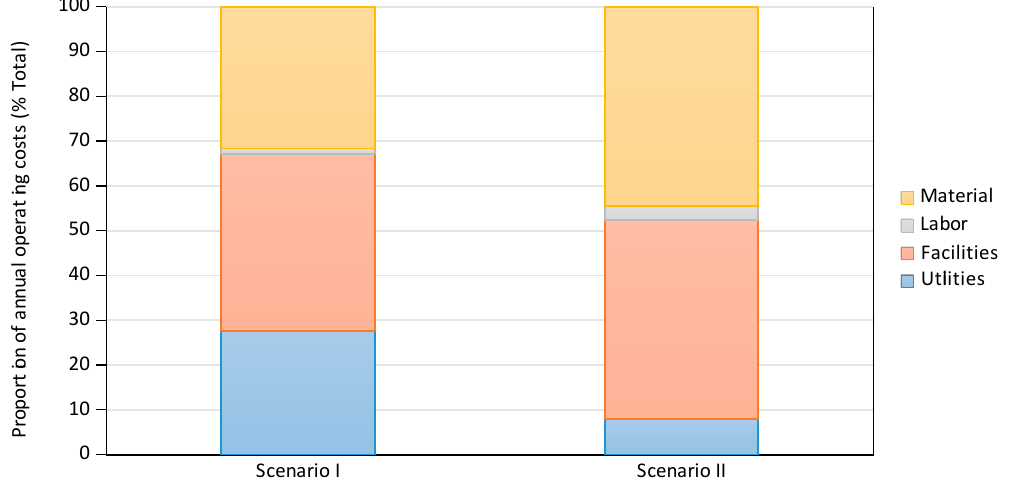
Figure 4. Proportion of annual operating costs for Scenario I (evaporation process) and Scenario II (flocculation process).